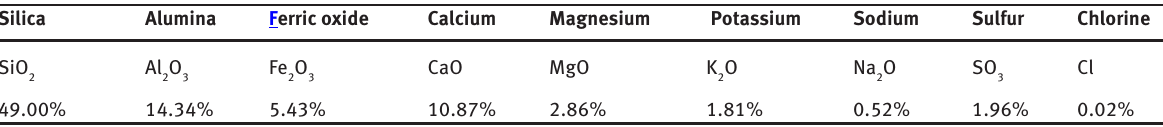
Table 3: Chemical composition of minerals. Silica Alumina Ferric oxide Calcium Magnesium Potassium Sodium Sulfur